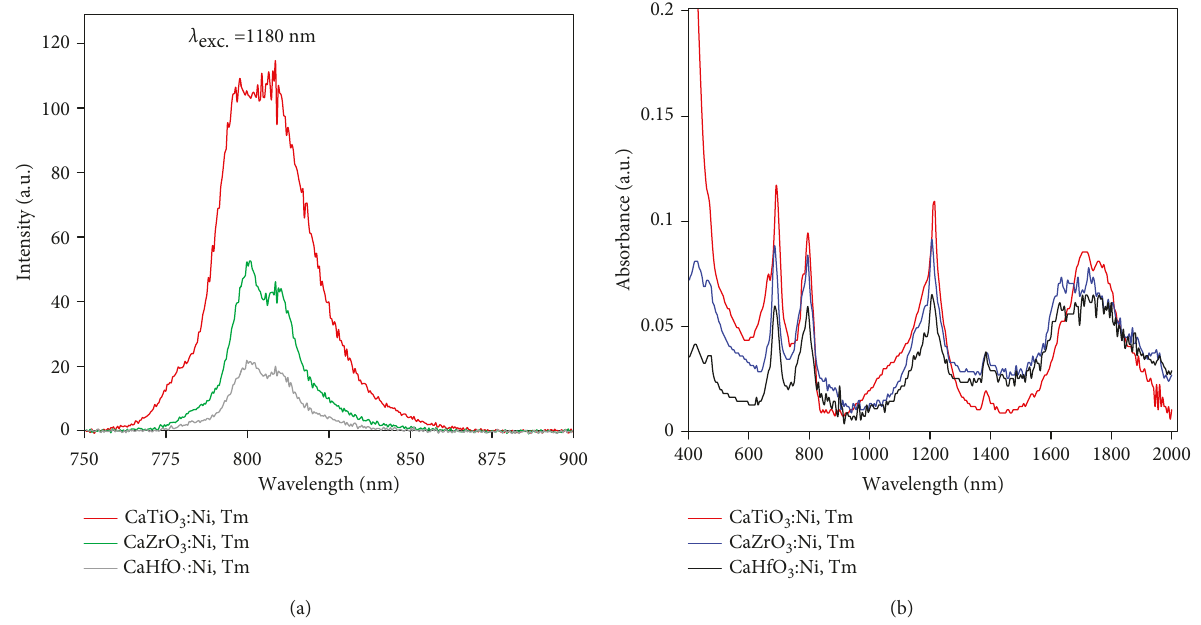
Figure 9: (a) UC emission and (b) absorption spectra of the Ca (Ti/Zr/Hf)O